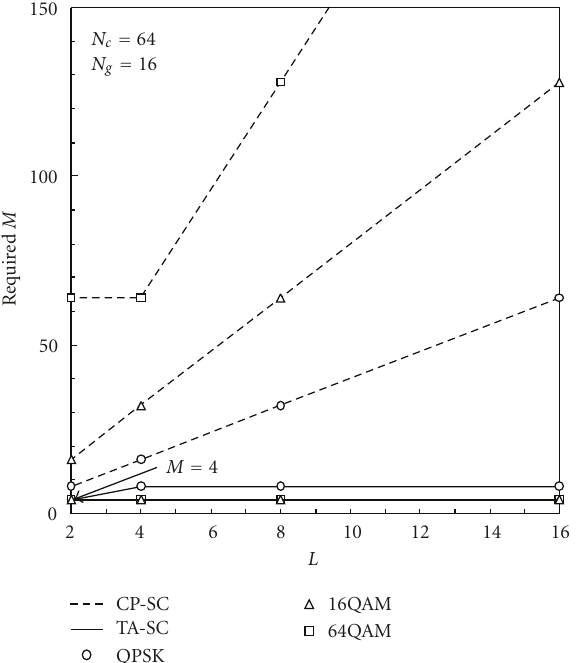
Figure 8: Required M as a function of the number L of propagation paths.